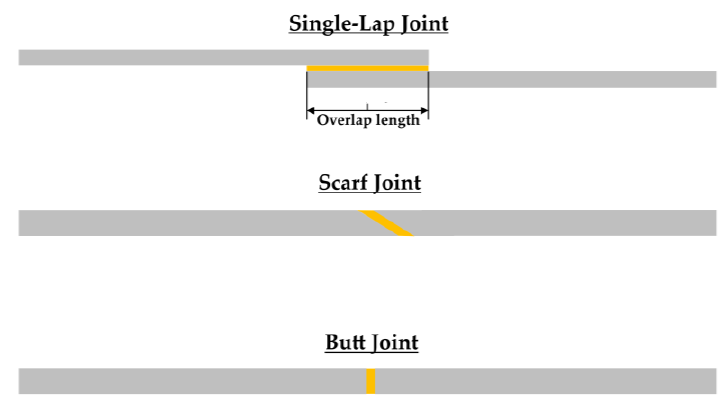
Figure 1. Basic types of adhesively bonded joints.